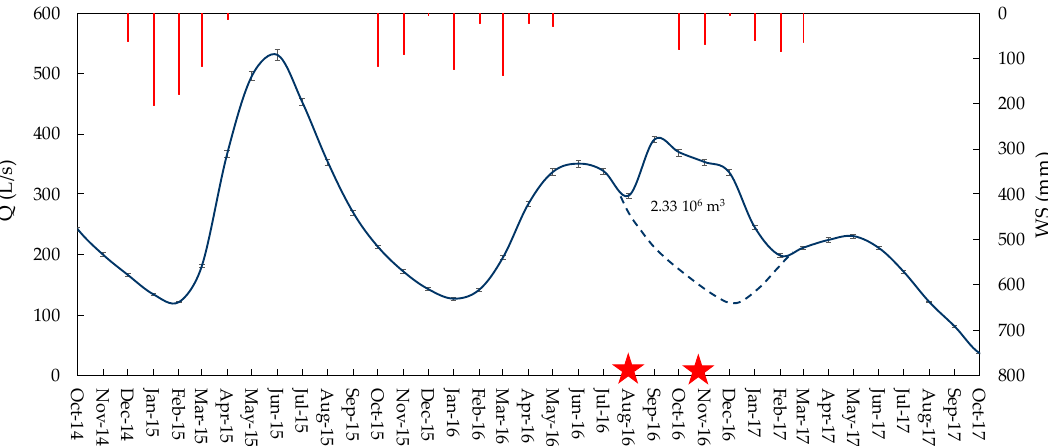
Figure 4. Estimation of excess outflow from October 2016 to February 2017. The red bars represent the estimated monthly water surplus (WS). The blue line represents the mean monthly discharge (Q). The dashed blue line represents the hypothetical spring hydrograph if the depletion period was undisturbed by the earthquakes. The red stars indicate the 24 August 2016 M w 6.0 Amatrice earthquake and the 30 October 2016 M w 6.5 Norcia earthquake.